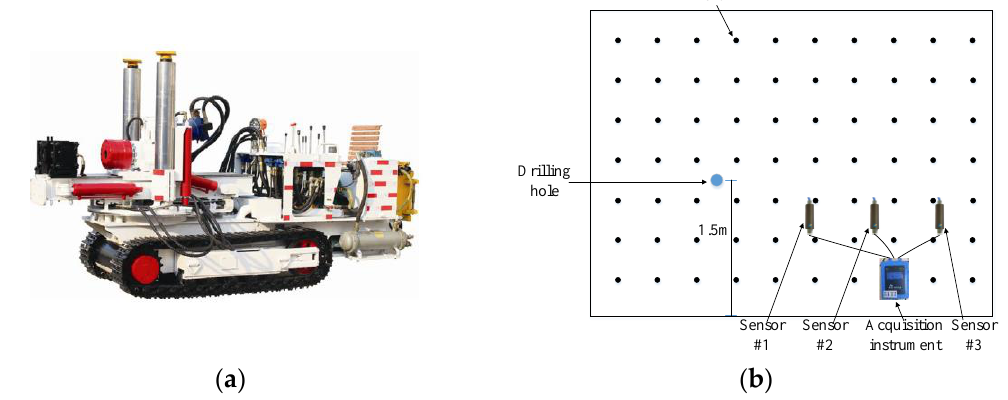
Figure 2. Drill rig and MS equipment layout. ( a ) CMS1-6500/75 drill rig; ( b ) Drill hole and MS equipment layout at roadway side.